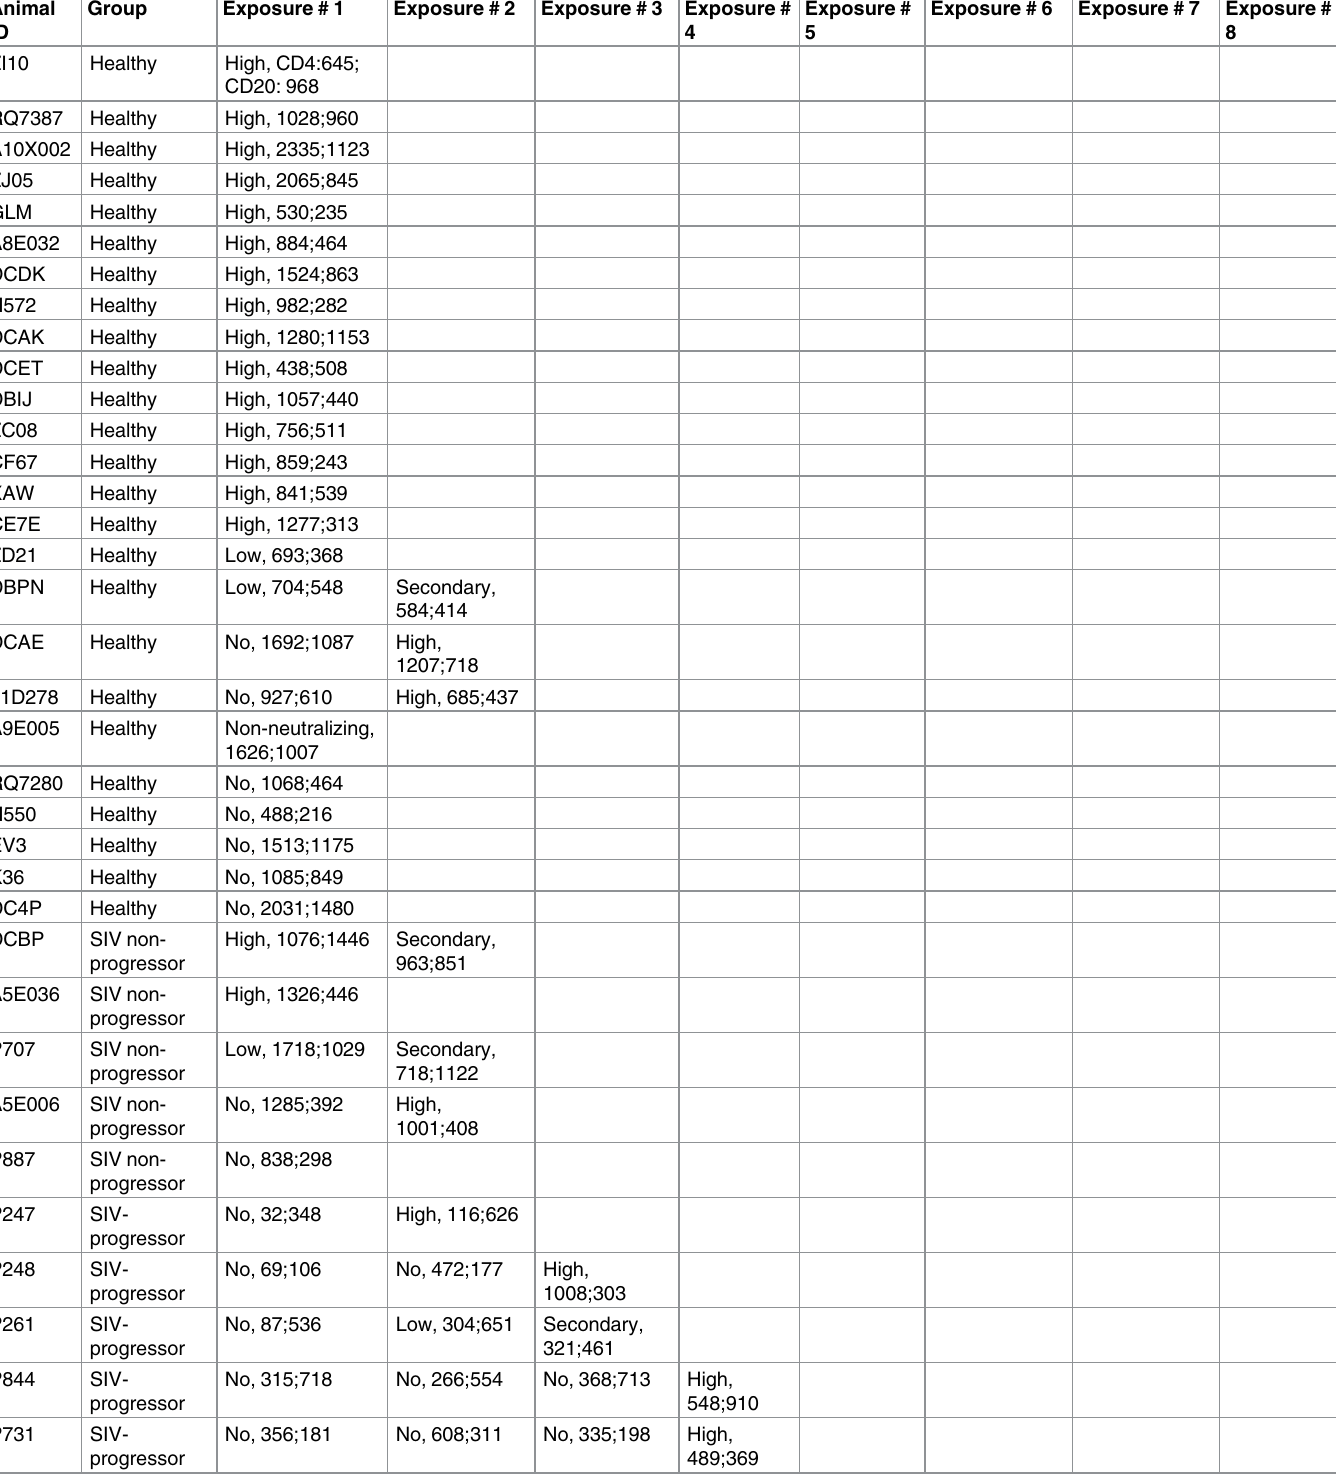
Table 1. Immune response outcome of total 118 exposures for all 49 macaques receiving F(ab 0 ) 2 radiotracers. Animal ID